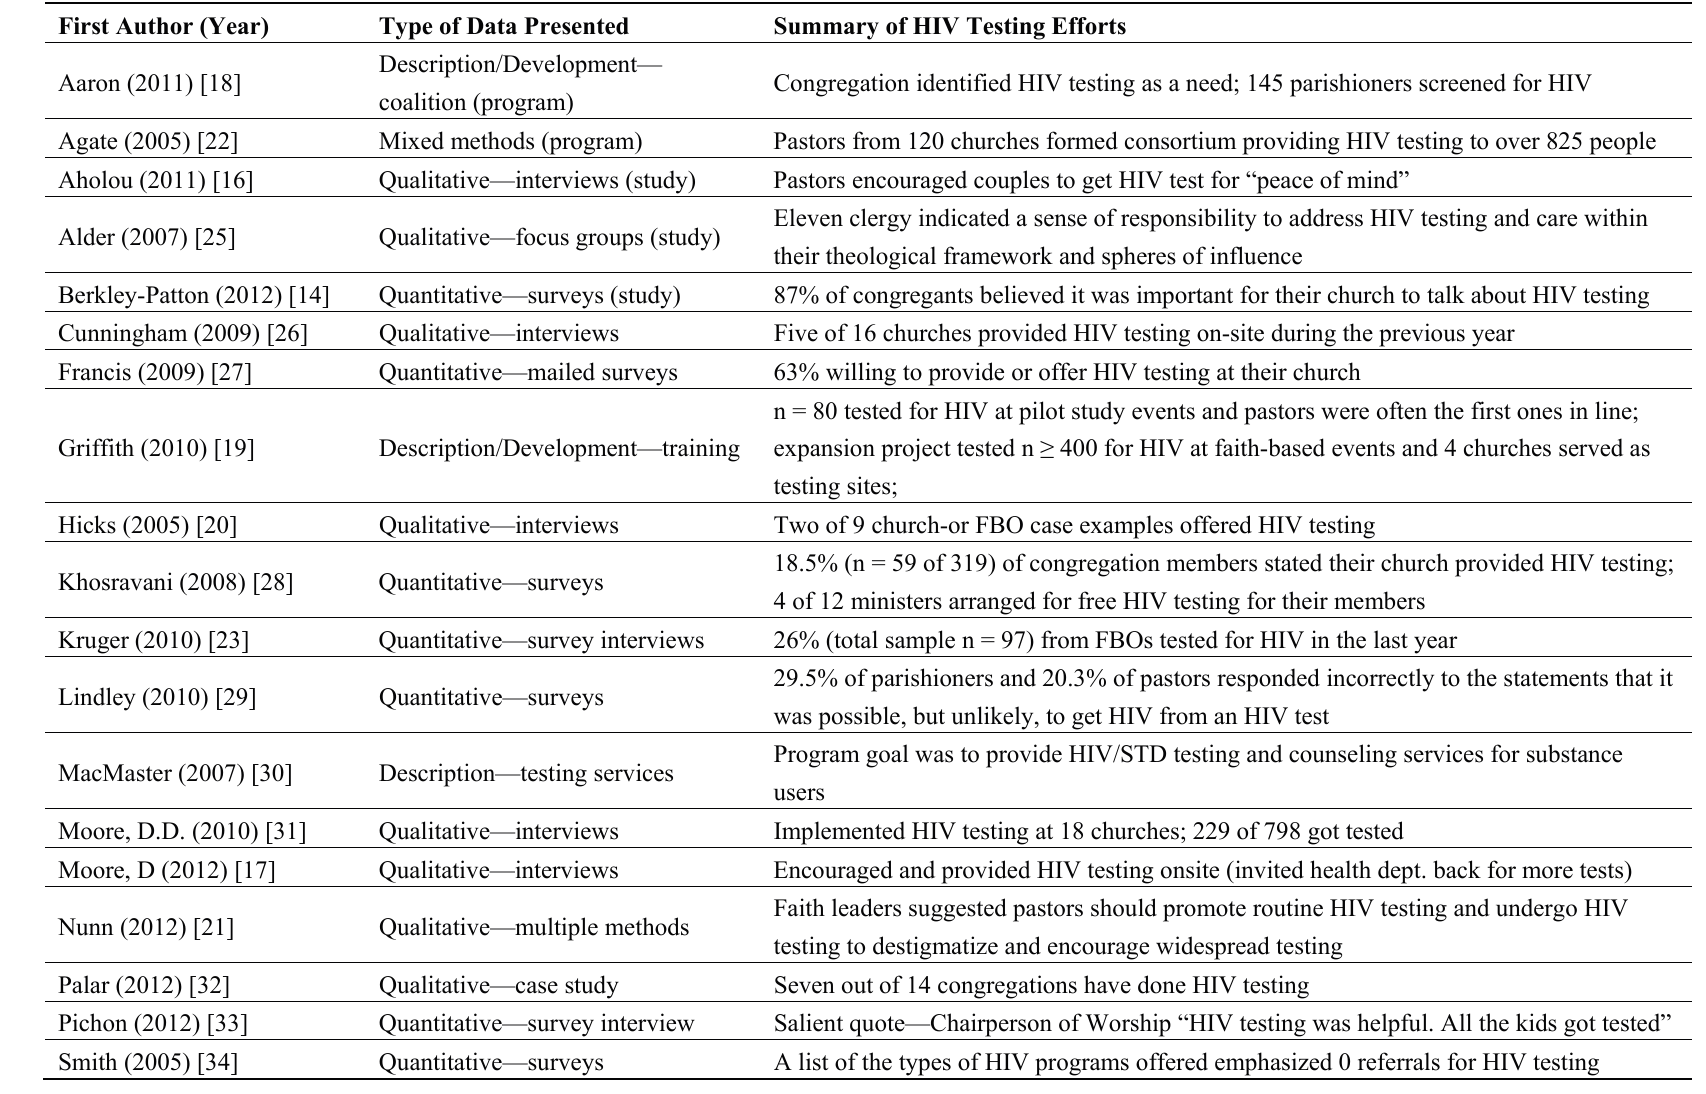
Table 1. HIV testing program/study